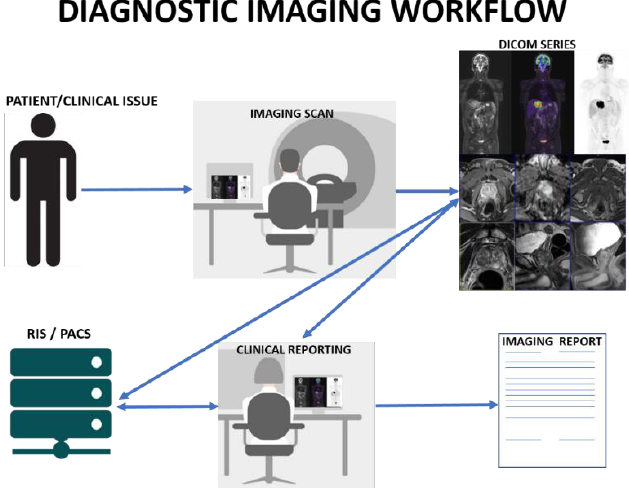
Figure 1. Diagnostic Imaging Workflow. Diagnostic images are acquired through an imaging device, stored in a standard picture archiving and communication (PACS) and radiological information system (RIS) and therefore visually inspected on a digital imaging and communications in medicine (DICOM)/PACS viewer by a specialist (usually radiologists or nuclear physicians), who produces a structured or unstructured report representative of the clinical outcome of the examination.